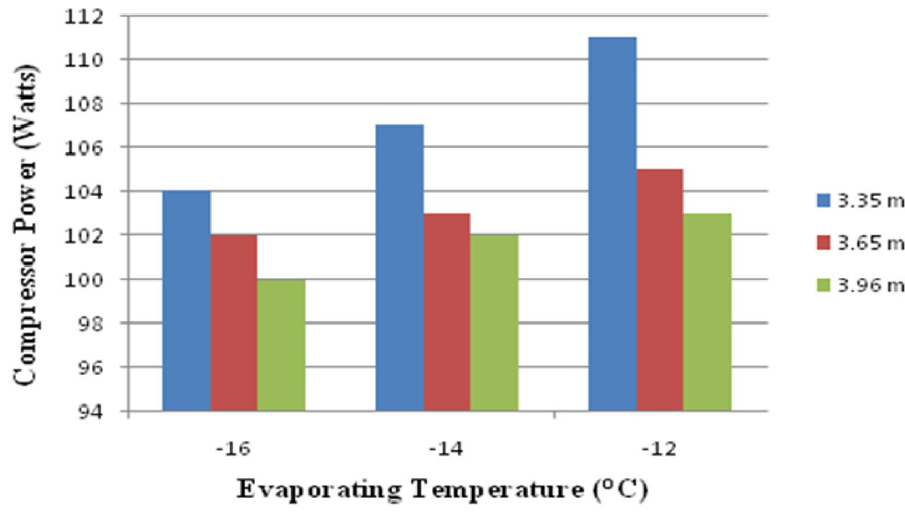
Figure 12. Variation of compressor power against capillary length and evaporating temperature.